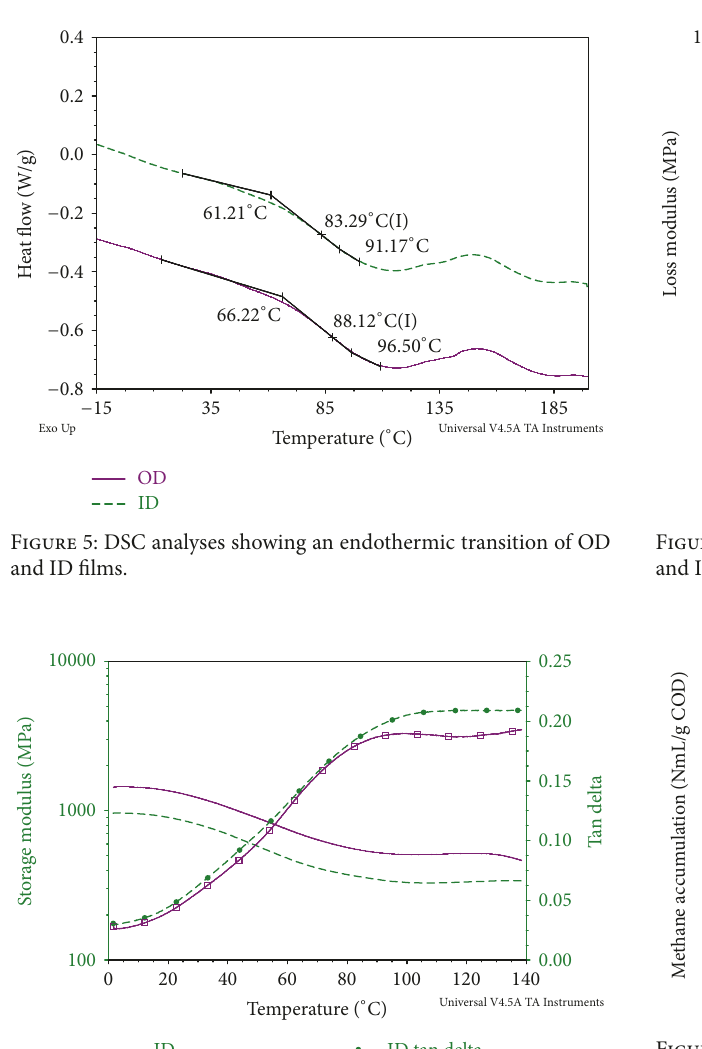
Figure 8: Anaerobic degradation of OD (full circles) and ID (empty circles) films, expressed in the accumulation of methane gas/g COD over a period of 30 days at 55 ∘